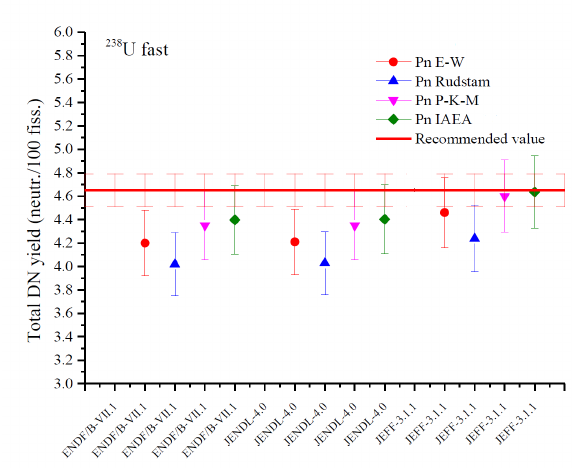
Figure 2. Total delayed-neutron yields calculated using the sum- mation method for fast n-induced fission of 238 U. The di ff erent symbols are obtained using di ff erent P n compilations: Wilson and England [21] (red circles), Rudstam et al. [22] (blue trian- gles), Pfei ff er et al. [23] (magenta triangles), CRP data [6] (green diamonds). The fission yield data were obtained from the evalu- ated libraries ENDF / B-VII.1, JENDL-4.0, and